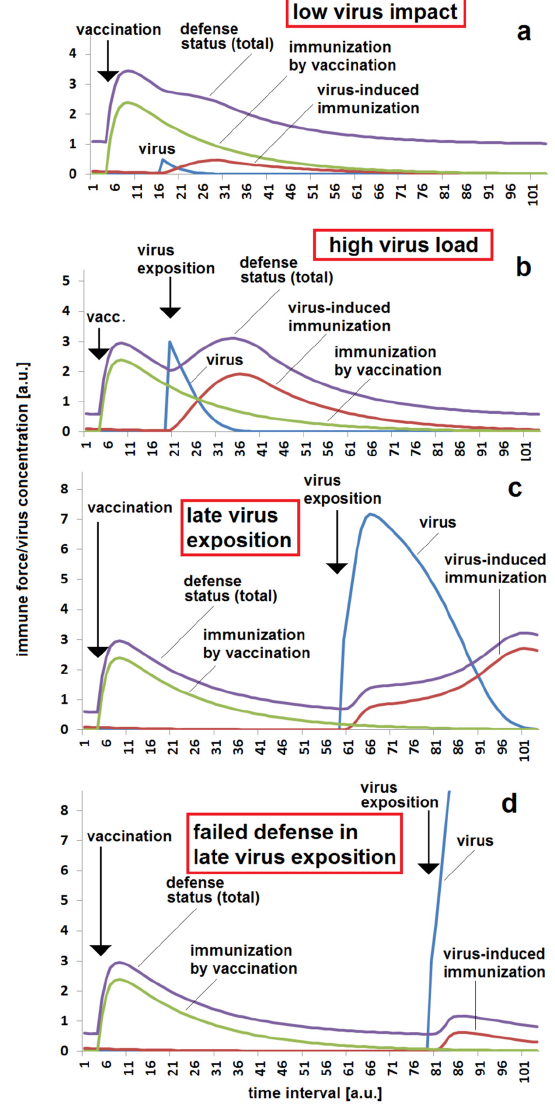
Figure 1. Immunization status with respect to time between vaccination and virus exposition: ( a ) low viral impact a short time after vaccination, meaning successful protection by vaccination, small additional stimulation of immune system by the viral impact; ( b ) high viral impact a short time after vaccination, meaning successful protection by vaccination, considerable additional stimulation of immune system by the viral impact; ( c ) strong reaction after a longer time between vaccination and virus exposition, but survived illness; ( d ) non-sufficient defense reaction when there is a long time between vaccination and virus exposition, resulting in serious illness. The same parameter set was used for all four simulations ( a – d ): k vir = 0.3; k r = 0.12; k st = 0.12; D vacc = 0.05; D AB = 0.05; c BGim = 0.5; v oo = 30; st oo = 10.